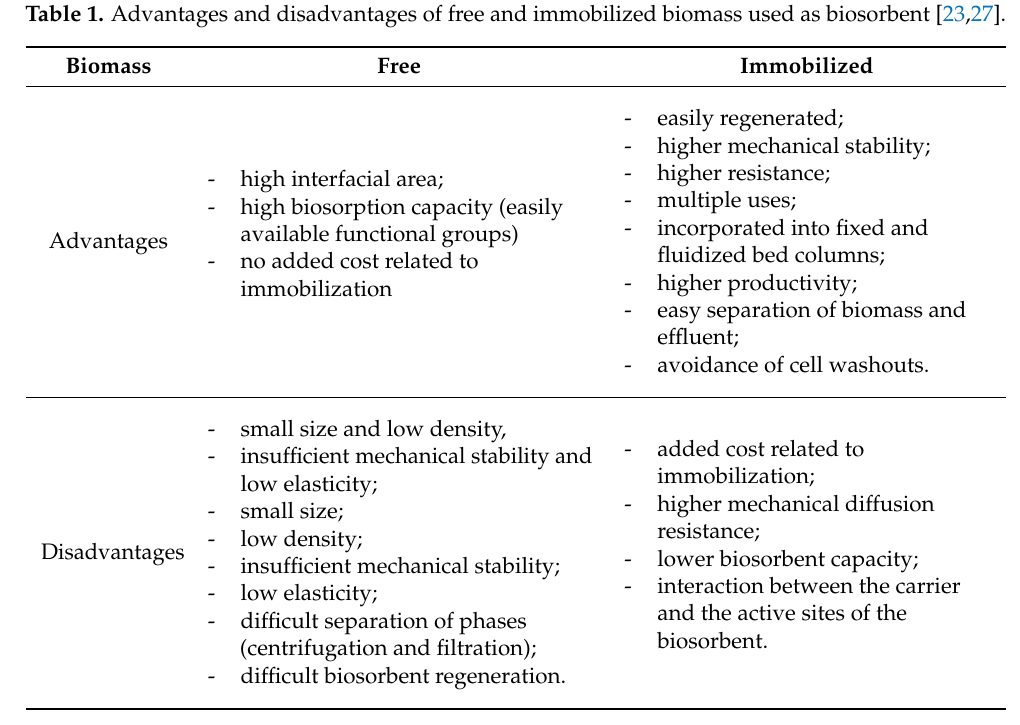
Table 1. Advantages and disadvantages of free and immobilized biomass used as biosorbent